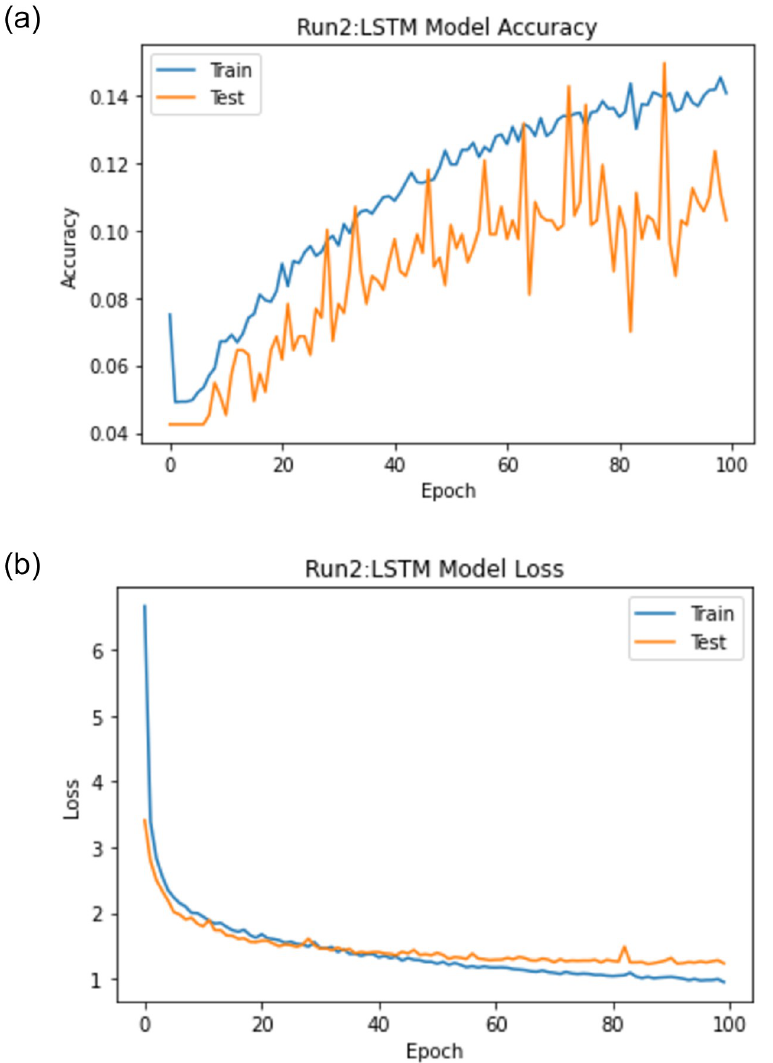
Fig 15. The LSTM-GWO accuracy and loss with experiment